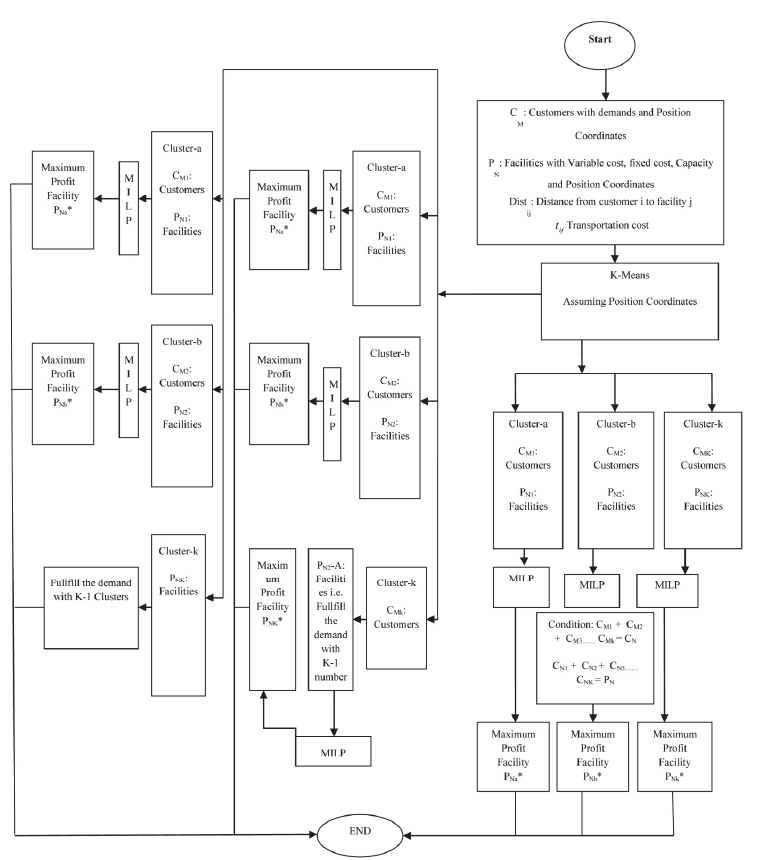
Fig. 1. shoes the flow chart of the proposed approach for